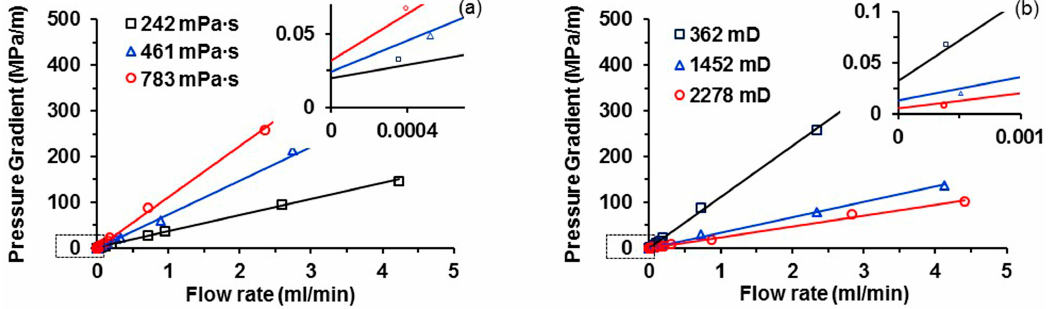
Figure 10. Single-phase flow curves of heavy oil: ( a ) at different viscosities, k = 362 mD; and ( b ) at different permeabilities, µ o = 783 mPa · s.